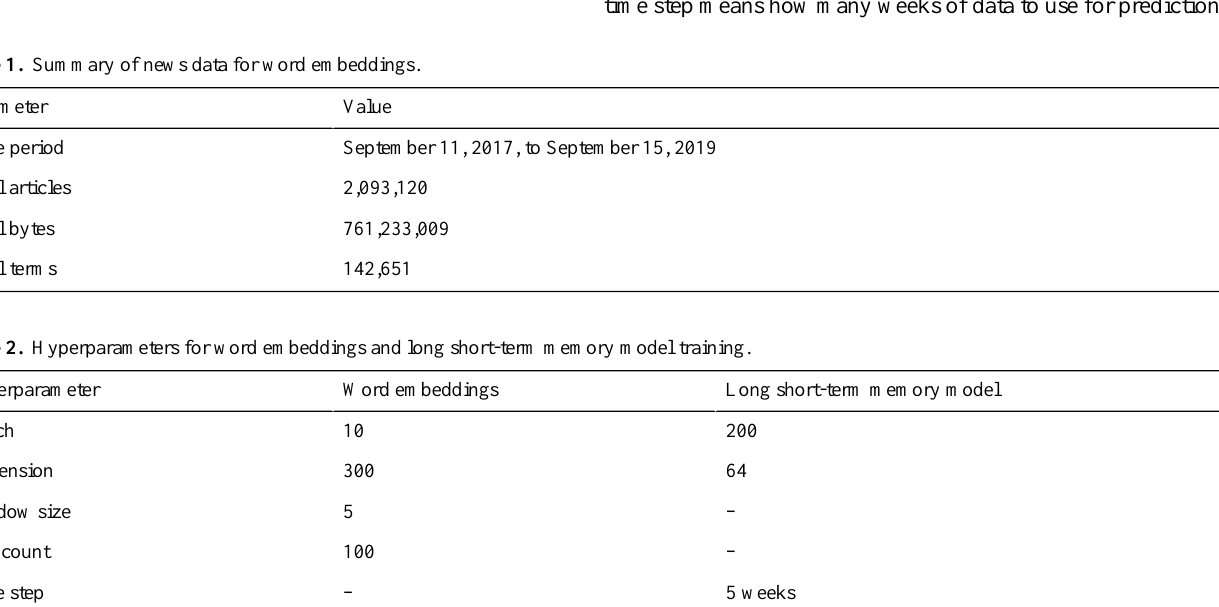
Table 1. Summary of news data for word embeddings.